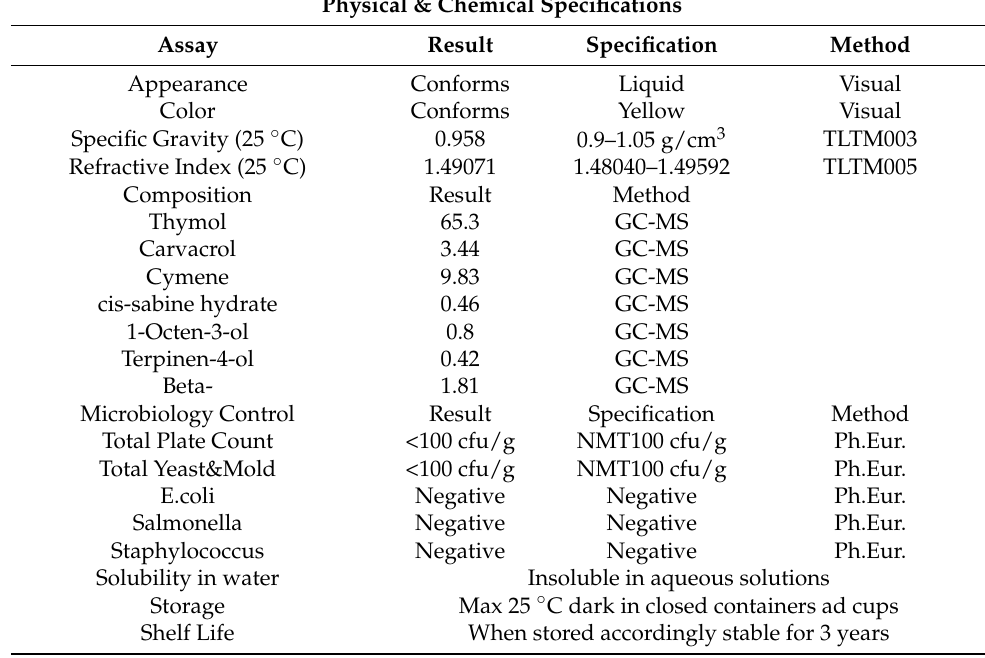
Table 1. Certificate of analysis of T. vulgaris